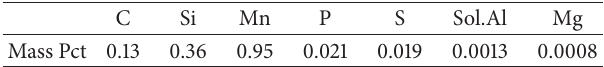
Table 1: Chemical composition of steel sample (mass